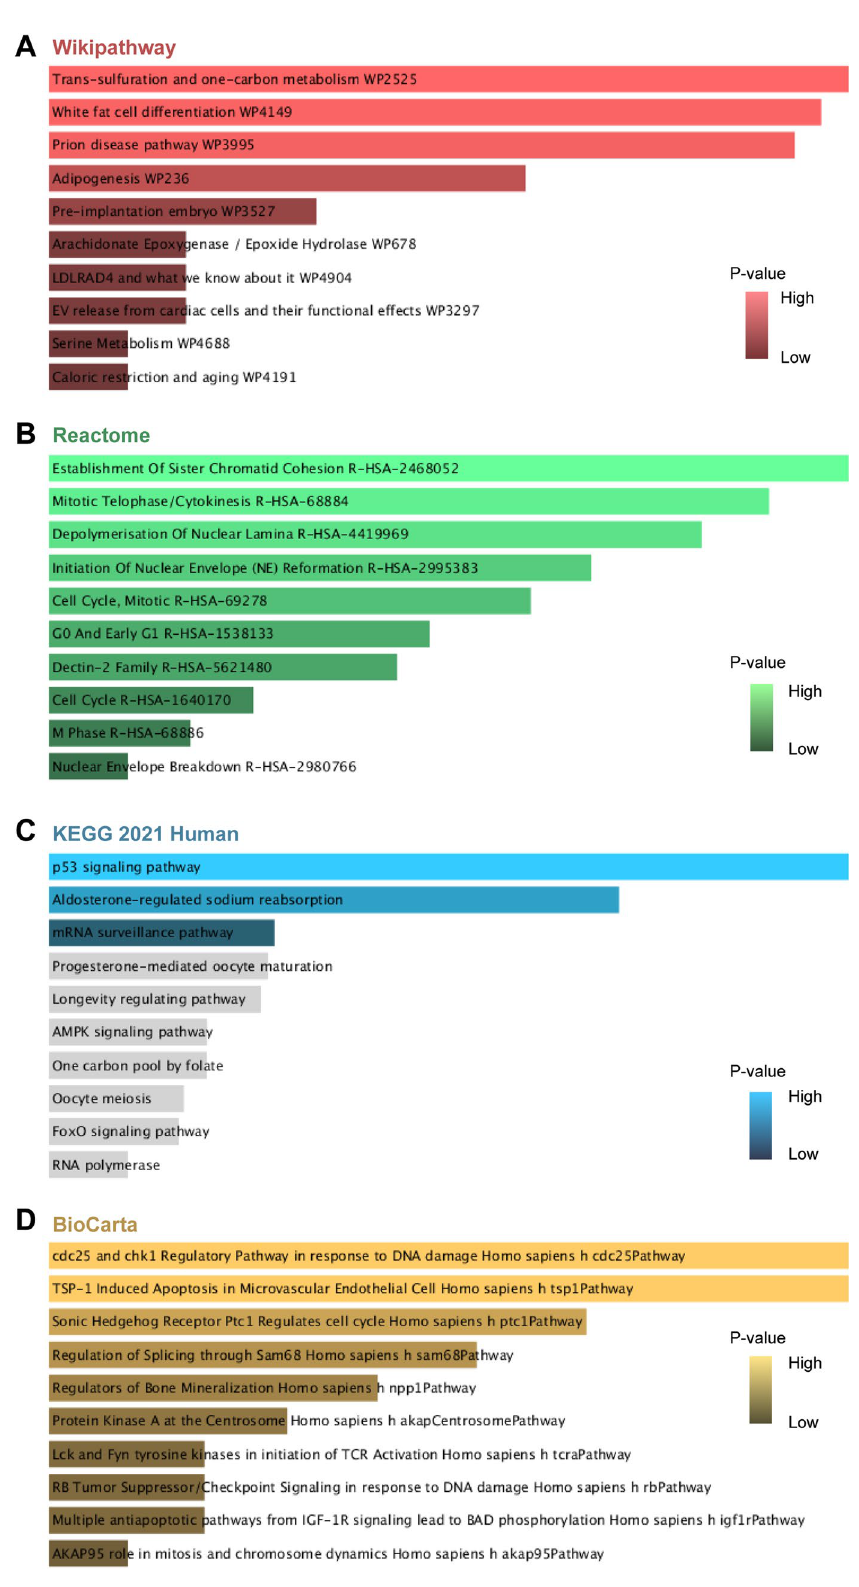
Figure 4. Pathway enrichment analysis of common genes between EBV infection, SLE and DLBCL. ( A ) Wikipathway, ( B ) Reactome Pathway, ( C ) KEGG Human Pathway, ( D ) BioCarta